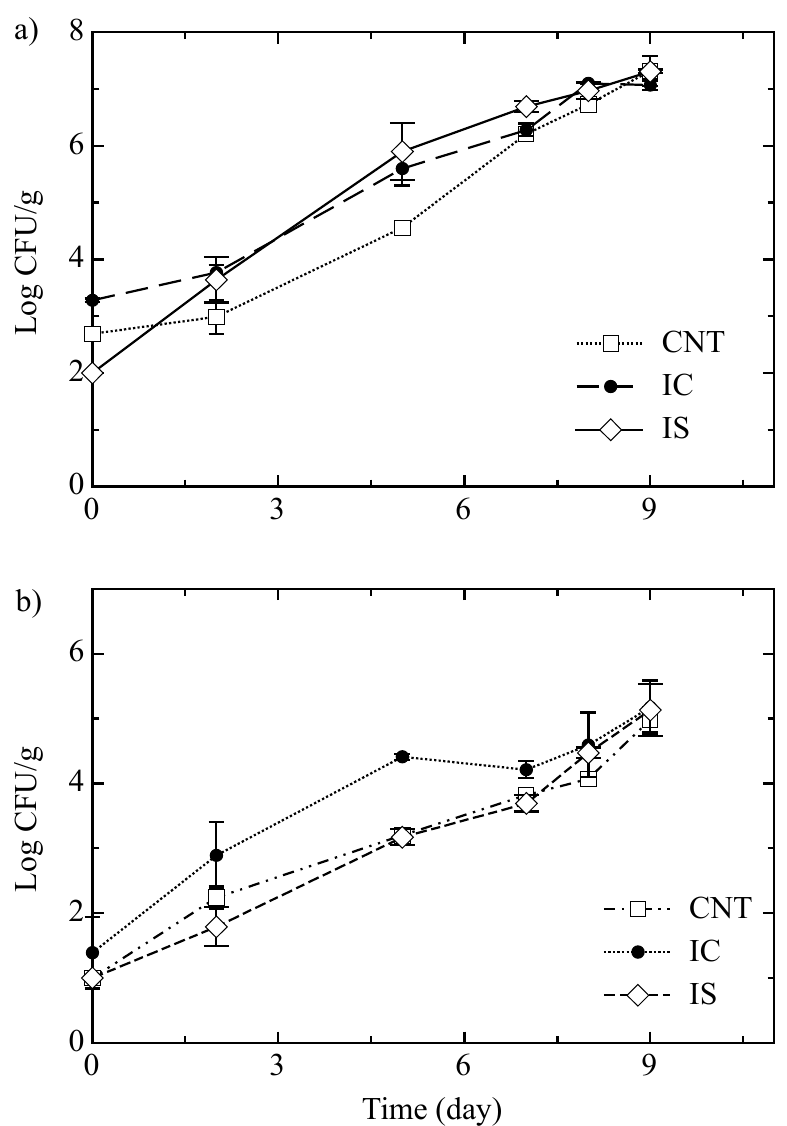
Figure 4. Growth curves of Pseudomonas spp. ( a ) and Enterobacteriaceae ( b ) in fiordilatte cheese with inulin from chicory (IC), inulin from cardoon (IS) and without inulin (CNT). Values are means of four replications ± standard deviation.